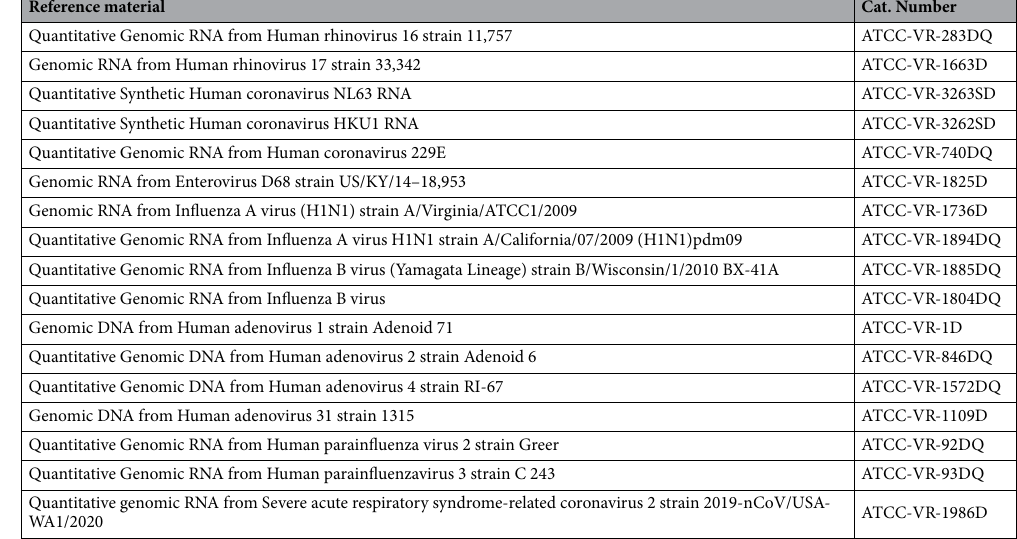
Reference material Cat.